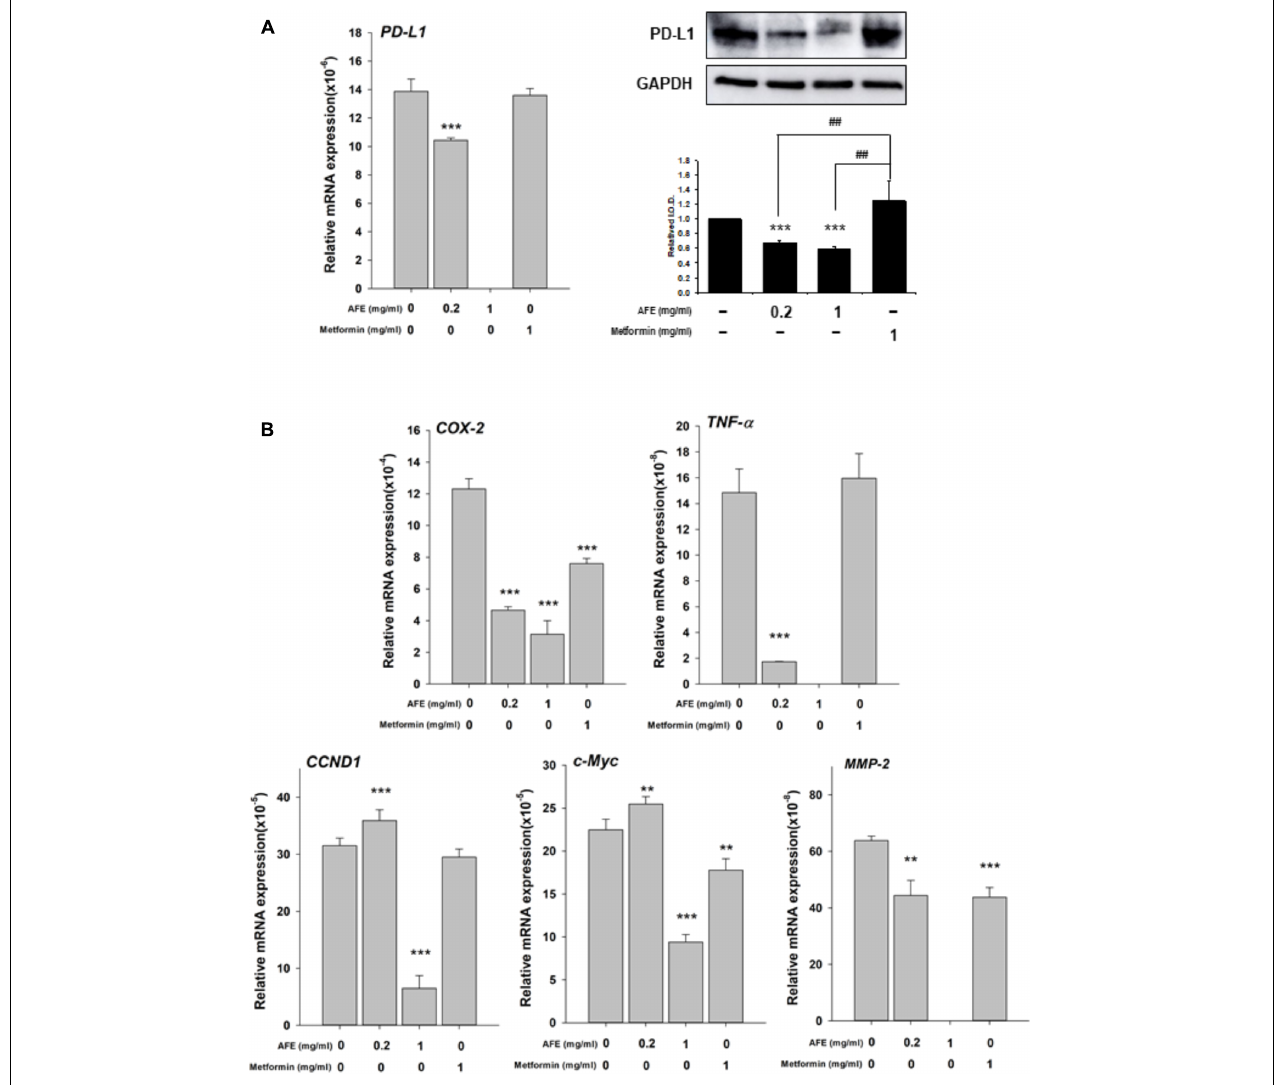
FIGURE 5 | Anoectochilus formosanus extract inhibits expression of PD-L1 , inflammatory and proliferative genes in oral cancer SCC25 cells. SCC-25 cells were treated with different concentrations of AFE or metformin with refreshed media with agents daily for 3 days. Total RNA and protein were extracted. qPCR and Western blotting analysis were performed for (A) PD-L1 ( left hand panel ) and PD-L1 protein ( right-hand panel ). (B) Parallel studies were conducted as described in (A) . Total RNA was extracted and qPCR was performed for COX-2 , TNF- α , CCND-1 , c-Myc, and MMP-2 . Numbers of independent studies ( n = 3) ∗∗ p < 0.01, ∗∗∗ p < 0.001, as compared with control. ## p < 0.01, as compared with